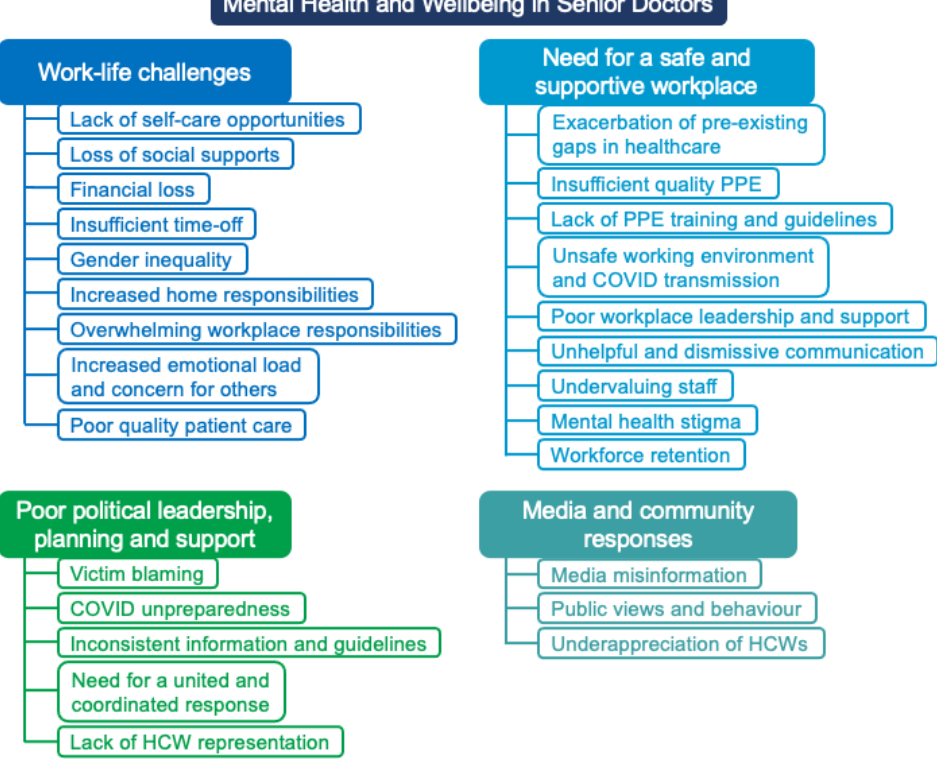
Figure 1. Themes: Mental health and wellbeing of Australian senior doctors during the COVID-19 pandemic.